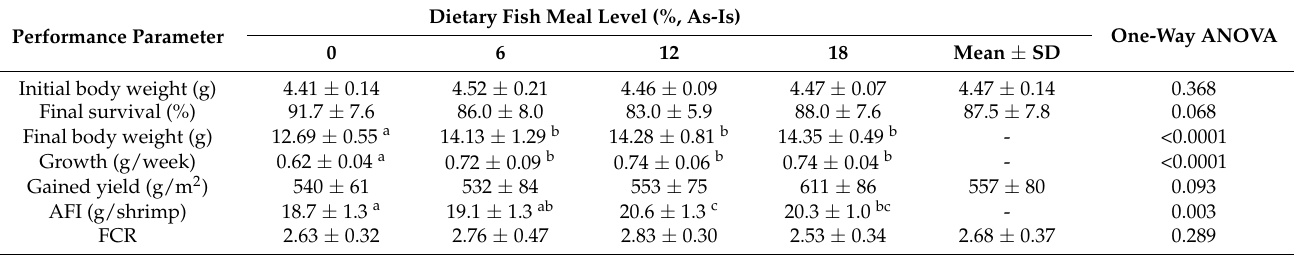
Table 7. Final shrimp growth performance (mean ± SD) in a clear-water recirculating indoor tank sys- tem as a function of dietary fish meal (FML) level. Shrimp were raised for 93 days with 70 shrimp/m 2 in 60 L tanks to determine feed digestibility. Different letters in the same line indicate statistically significant differences according to Tukey’s HSD test at α = 0.05.